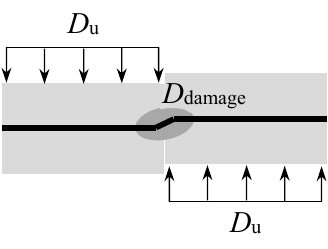
Figure 13. Mechanical diagram of dowel action.